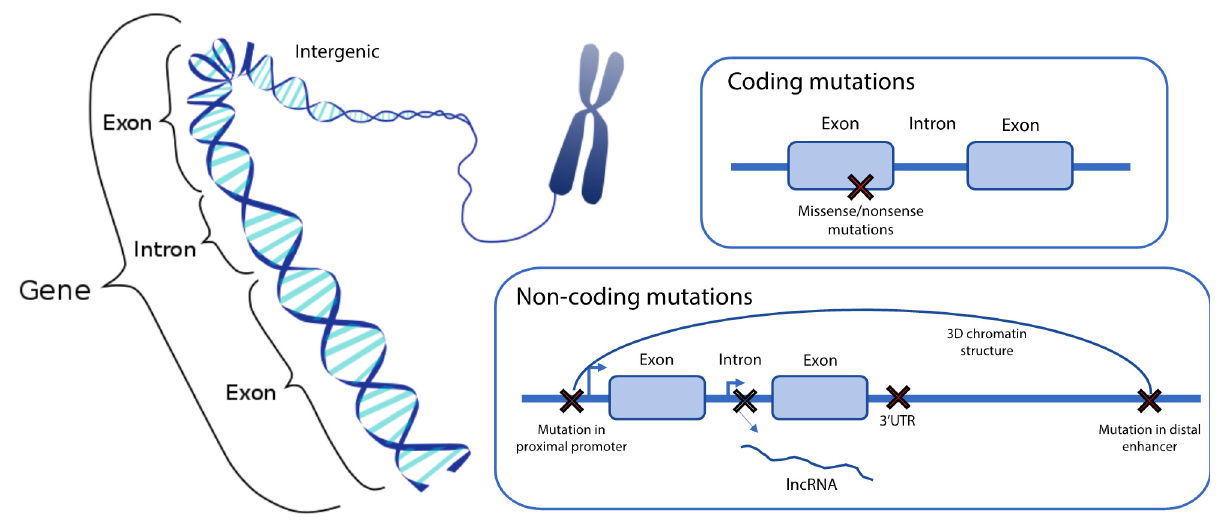
Figure 3. Schematic representation of genetic variants caused by mutations in coding/non-coding regions of the genome. Adapted DNA diagram (CC BY-SA 4.0 license, Smedib).